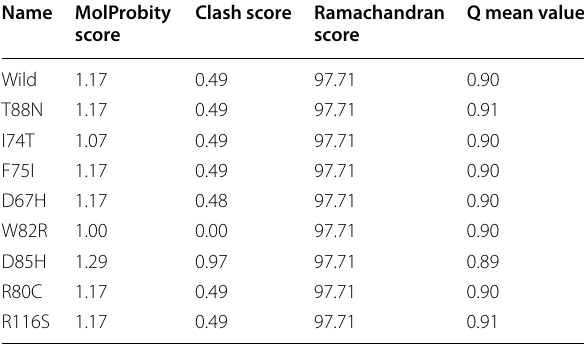
Table 5 Homology modeling scores as predicted by SWISS-